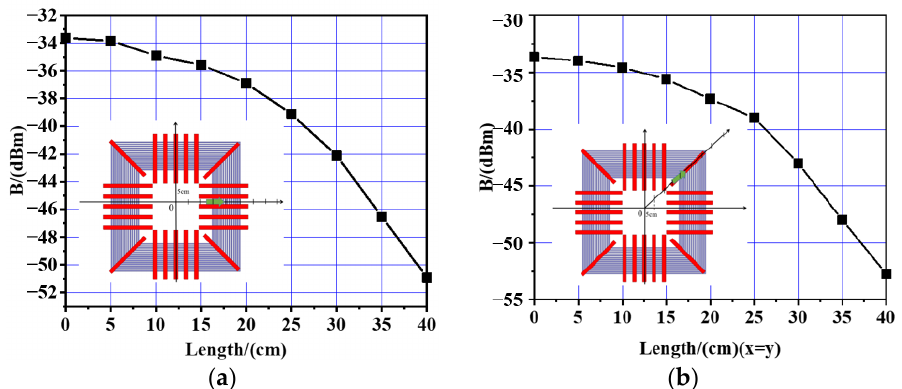
Figure 17. Magnetic field size without loading shielding aluminium plate, ( a ) transverse magnetic field, ( b ) diagonal magnetic field.